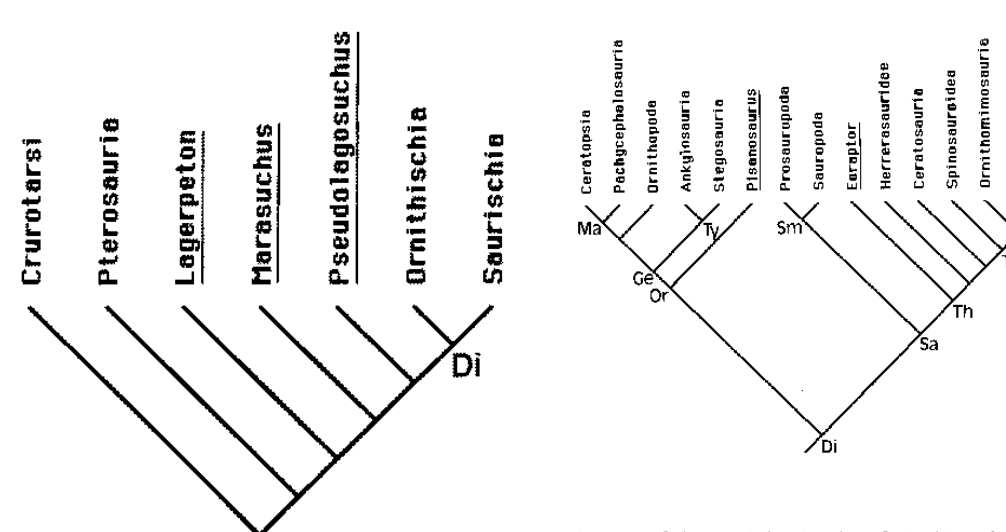
Fig. 8 – Cladogram indicating the relationships of the main dinosaur groups (based on Sereno 1999). Abbreviations: Co - Coelurosauria; Di - Dinosauria; Ge - Genasauria; Ma - Marginocephalia; Or - Ornithischia; Sa - Saurischia; Sm - Sauropodomorpha; Te - Tetanurae; Th - Theropoda; Ty -